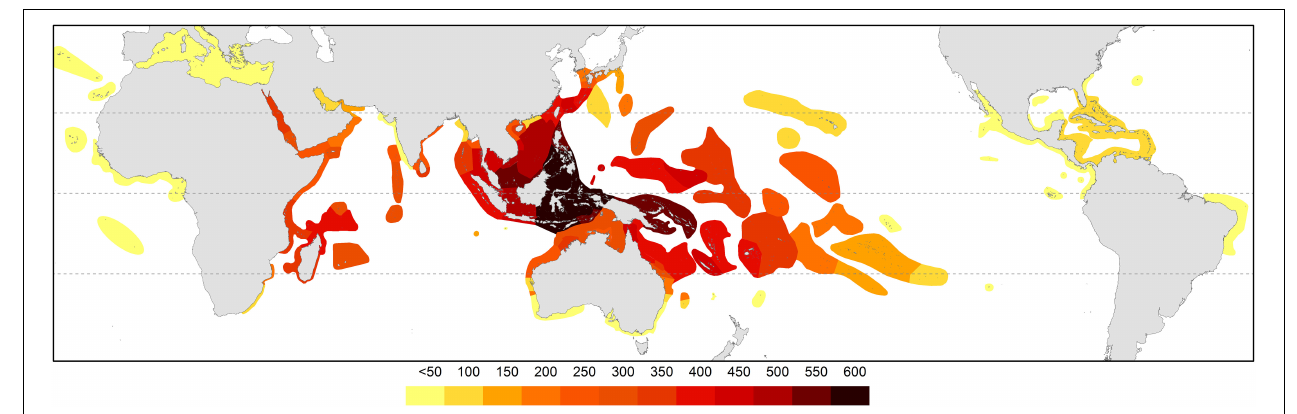
Figure 4, global diversity, was calculated by adding all records of occurrence (the addition of all species maps) using ArcMap